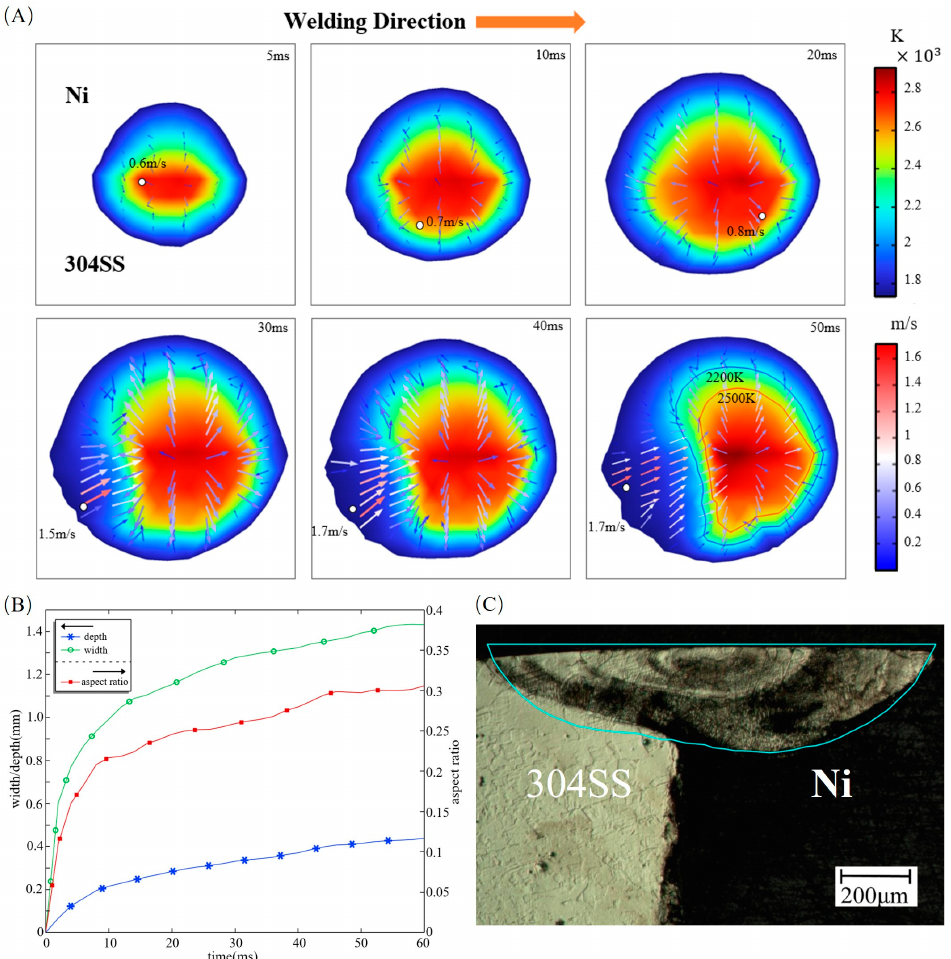
Figure 2. Evolution of the temperature field, the velocity field, and the dimensions and morphology of the molten pool. ( A ) Evolution of the temperature field and velocity field; ( B ) Dimensions of the molten pool; ( C ) Comparison between the simulated and experimental [17] cross-sectional profiles. Parameters: laser radius of 0.57 mm, welding speed of 20 mm/s, and laser power of 800 W.